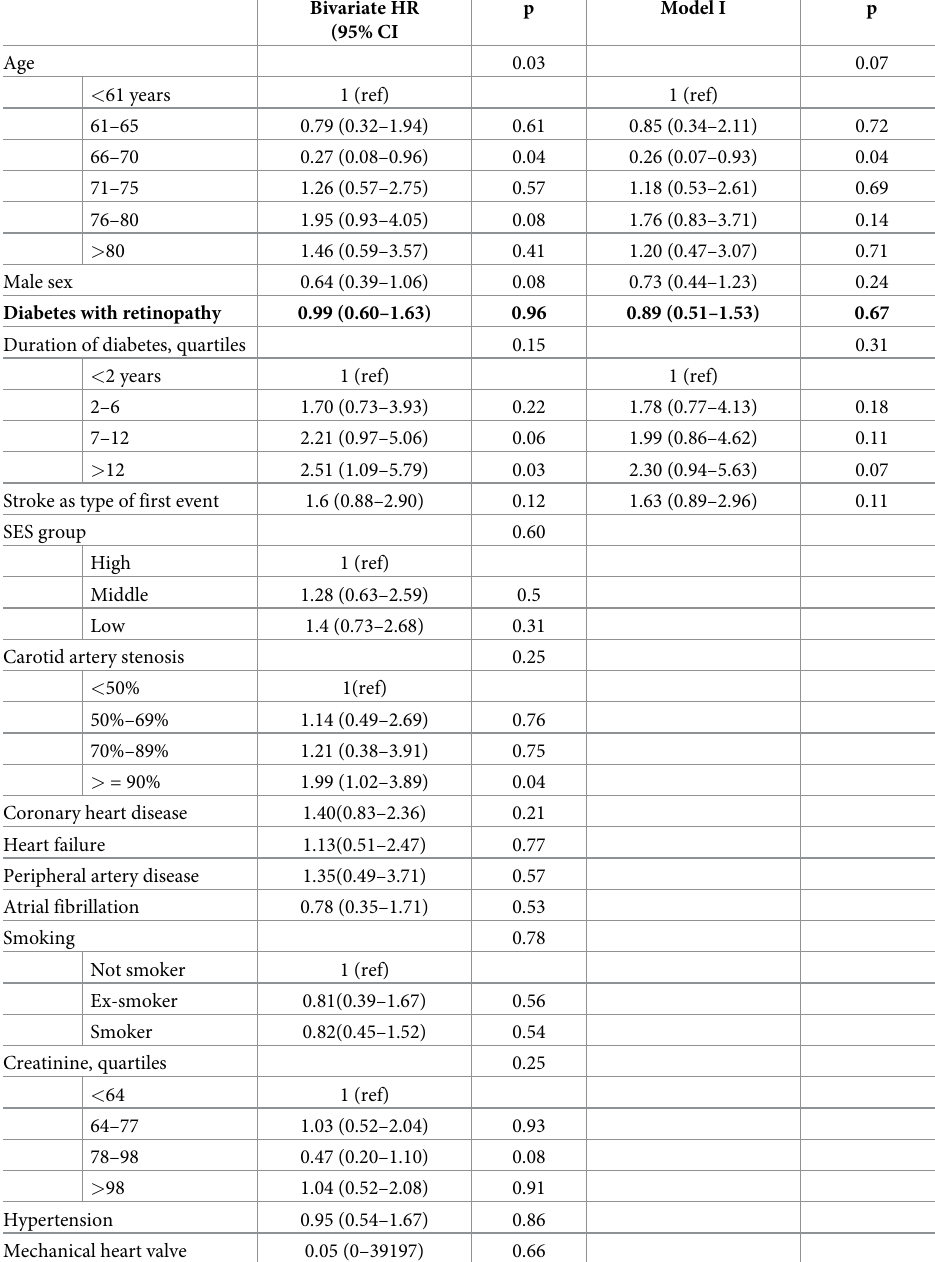
Table 3. Cox proportional hazards model in diabetes patients with recurrent stroke as